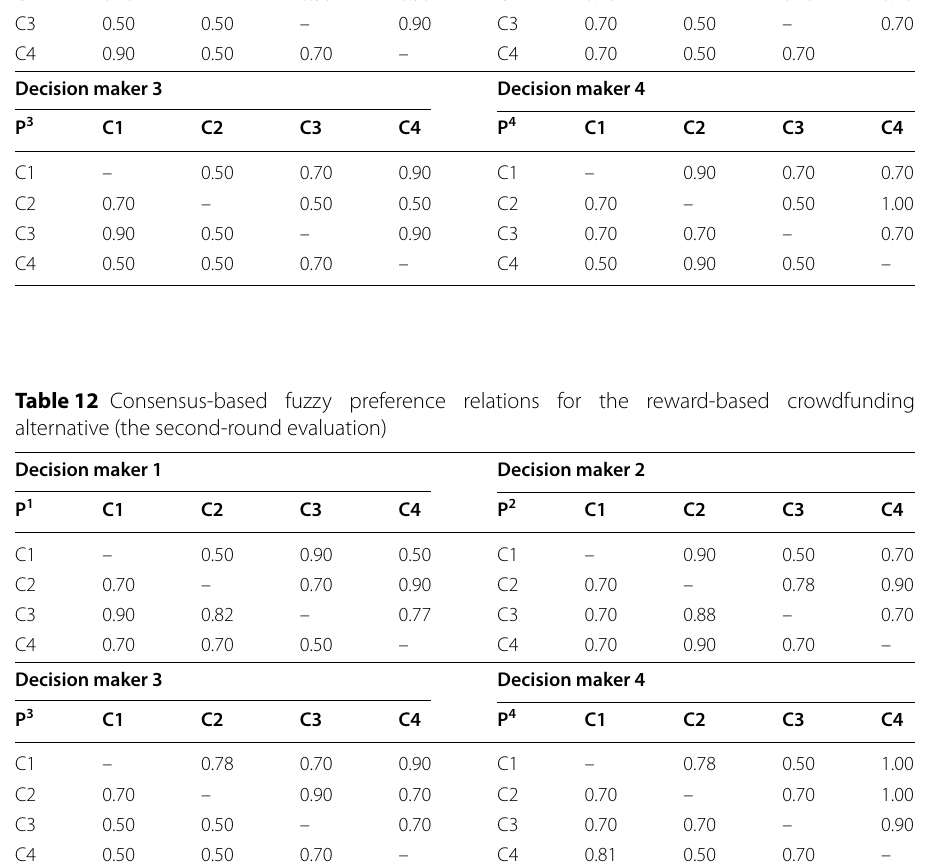
Table 11 Consensus-based fuzzy preference relations for the equity-based crowdfunding alternative (the first-round evaluation) Decision maker 1